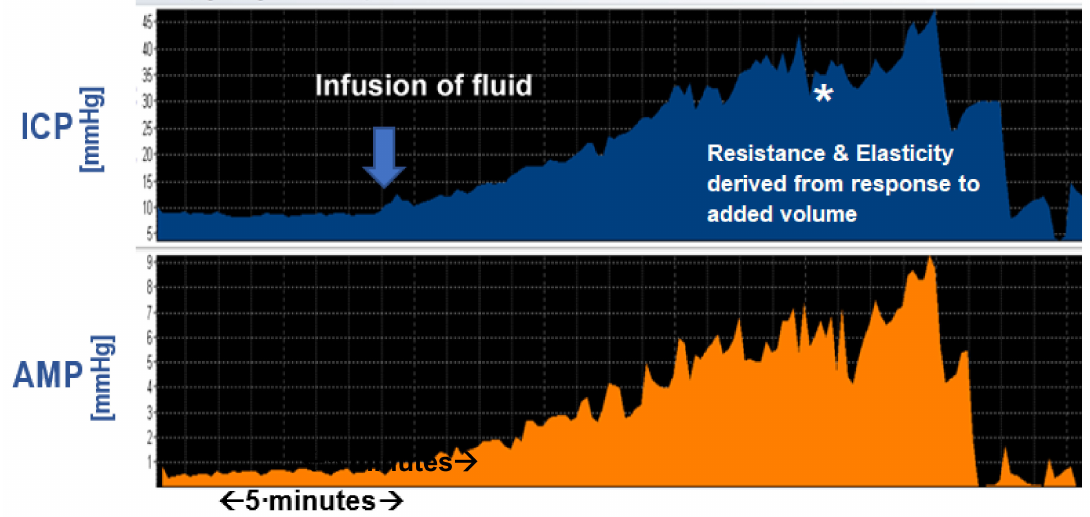
Figure 1. Infusion study recording. Baseline recording of 10–15 min, followed by infusion (starting from arrow) of fluid (Hartmann’s/Normal Saline) with constant rate (1.5 mL/min) until pressure reaches plateau. Resistance to CSF outflow (Rout) is calculated from the difference of the plateau and baseline pressure, divided by the infusion rate. Elasticity (“stiffness”) of the brain, is calculated from the pressure-volume curve produced during infusion. Each step of the grid represents 1 min in time, as marked on the x-axis. ICP: Intracranial Pressure. Amp: Fundamental harmonic of ICP Pulse